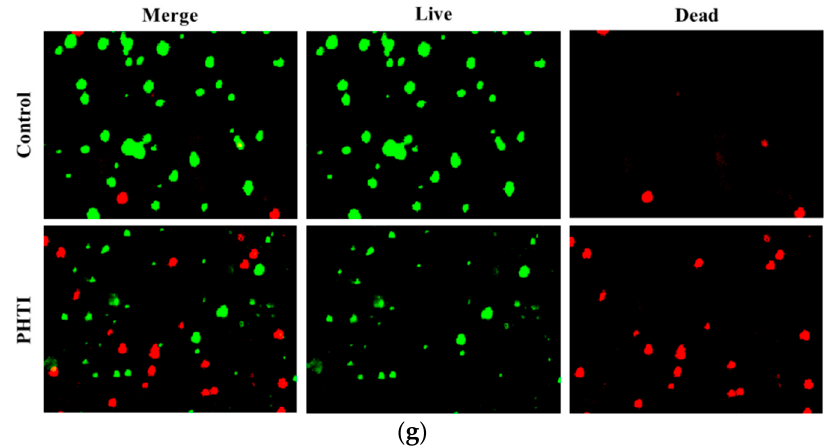
Figure 7. Antifungal activity of PHTI. Filter paper method for antifungals active against C. gloeosporioides ( a ) and F. oxysporum ( b ) ((1) Deionized water; (2) 0.1 mM of PHTI; (3) 0.25 mM of PHTI; (4) 0.5 mM of PHTI.) ( c ) Growth kinetics of C. gloeosporioides . ( d ) Total nucleotide leakage from C. gloeosporioides treated with 0.5 mM of PHTI. ( e , f ) Scanning electron microscopy (SEM) images of C. gloeosporioides treated with 0 and 0.5 mM of PHTI, respectively. ( g ) C. gloeosporioides viability visualized